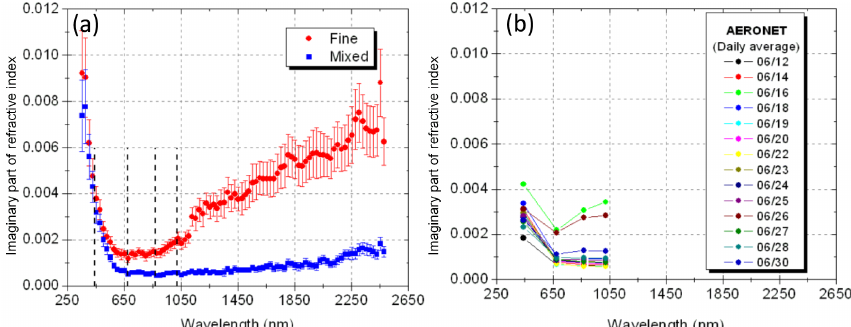
Figure 14. (a) Spectral imaginary part of the refractive index for Saharan dust from SS1 in Algeria. The dashed lines indicate wavelengths of AERONET retrievals. (b) AERONET (level 2.0) mean daily retrievals of imaginary part of refractive index from the collocated sun photometer for days in June 2011 (month/day). The outlier days exhibiting higher than average values correspond to 06/16 (bright green) and 06/26 (dark rust).